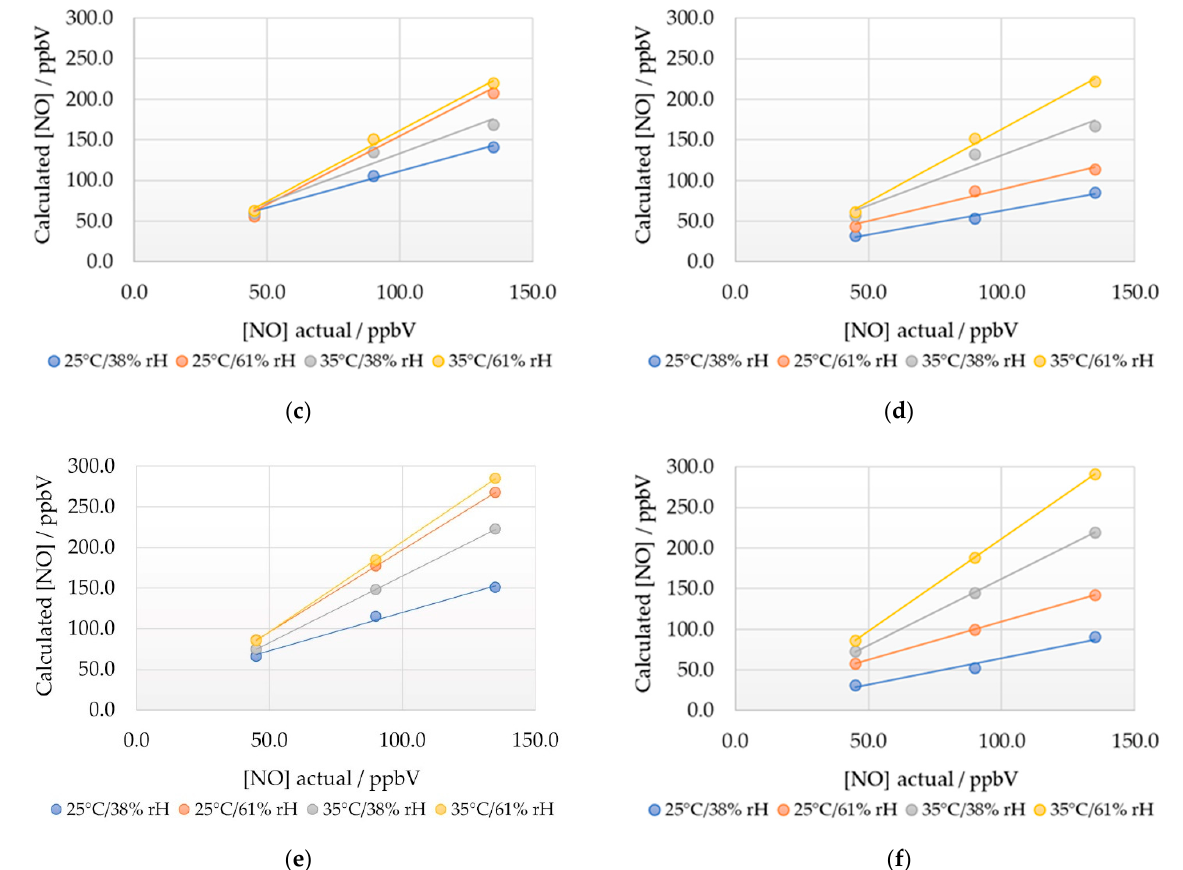
Figure 10. Calculated NO concentrations for three sensors under four different environmental conditions using the initially measured calibration curves, ( a )—Original sensor, ( c )—Sensor 2, ( e )— (Sensor 3) and using the NO working electrode to NO auxiliary electrode offset, gradient, and intercept surface functions from the initially measured calibration curves ( b )—Original sensor, ( d )—Sensor 2, ( f )—(Sensor 3).